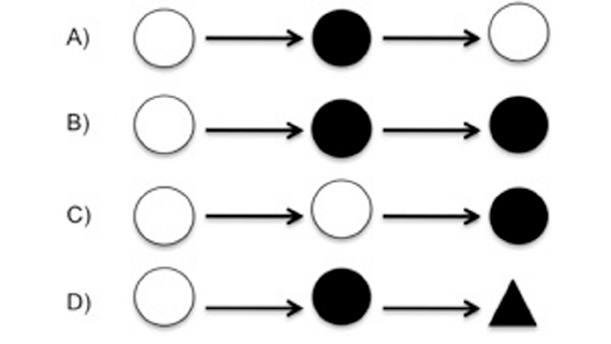
Fig. 2. Schematic diagram of brokerage role configurations for settlement categories. (A) Consultant: transfer from one category to the same category by a member of another category. (B) Gatekeeper: transfer from one category to another by a member of the receiving category. (C) Representative: transfer from one category to another category by a member of the sending category. (D) Liaison: transfer from one category to another by a member of a third